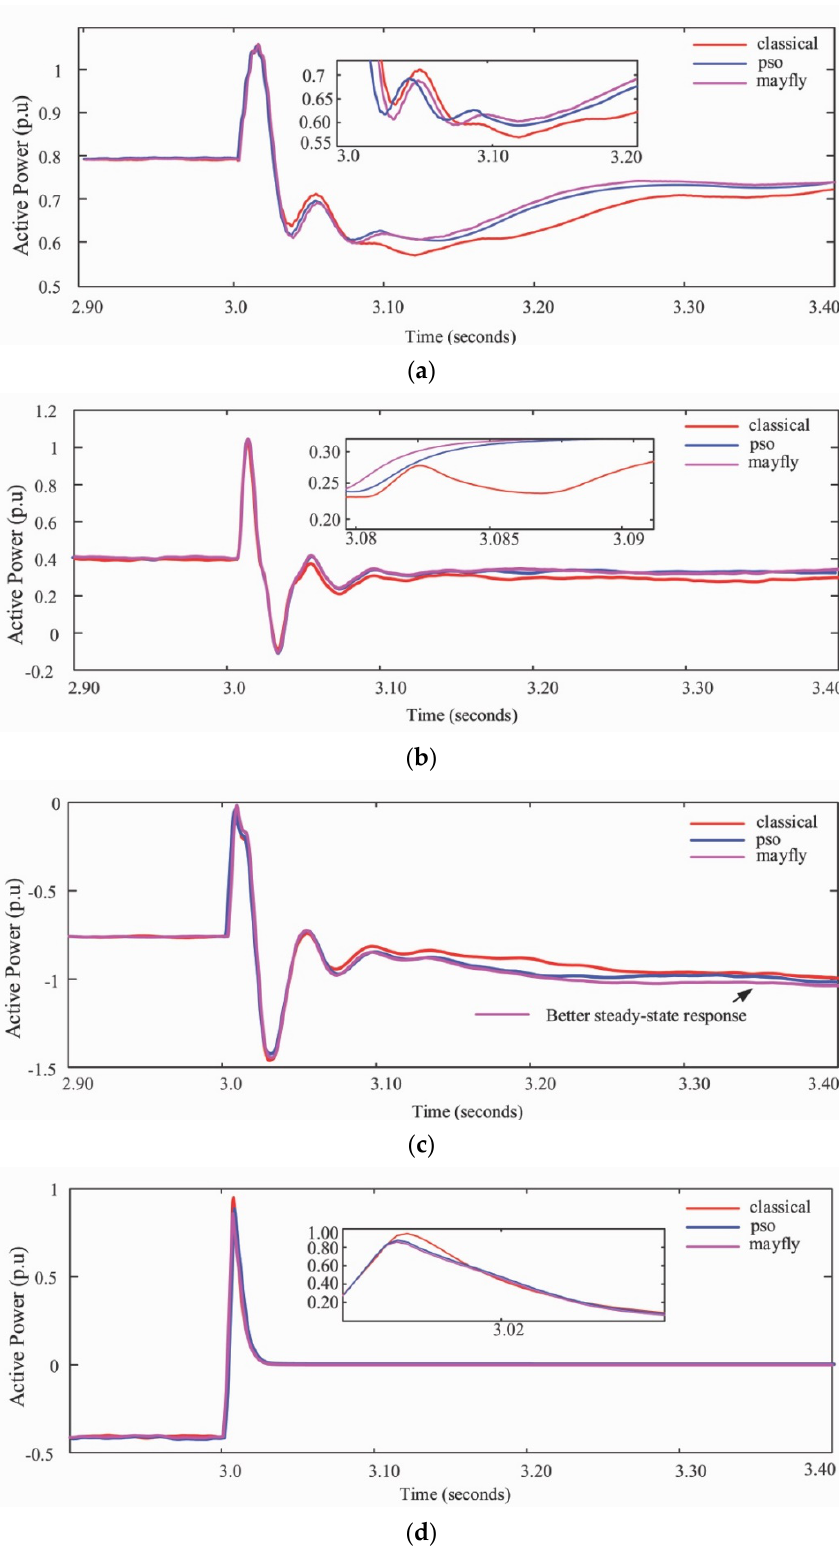
Figure 18. ( a ) Power fluctuation at wind farm 1, ( b ) power fluctuation at wind farm 2, ( c ) load-shifting profile at grid side 1, ( d ) load-shifting profile at grid side 2.